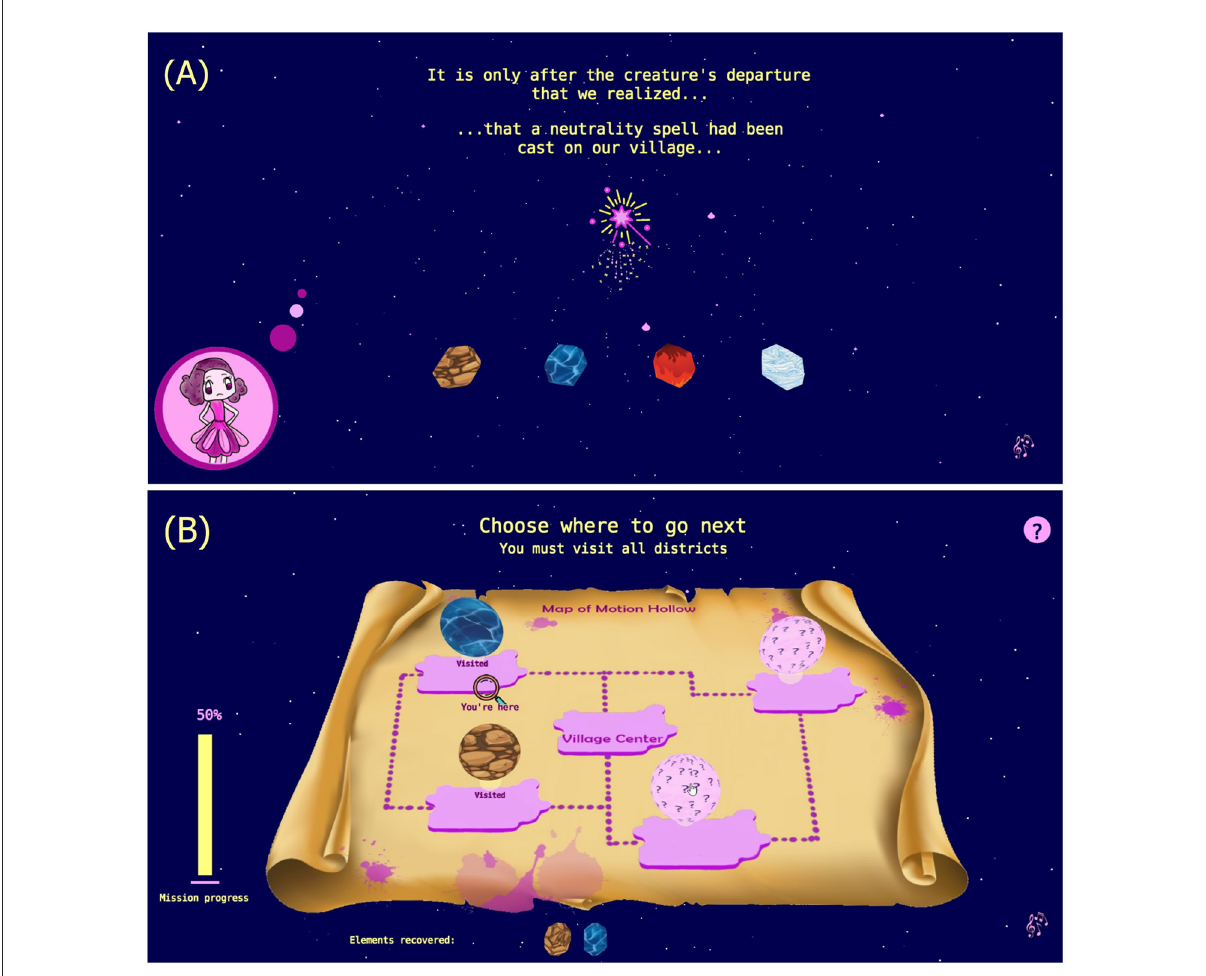
FIGURE4 Panel (A) depicts a screen from the storytelling part of the experience and panel (B) depicts the Motion Hollow map and progress elements.